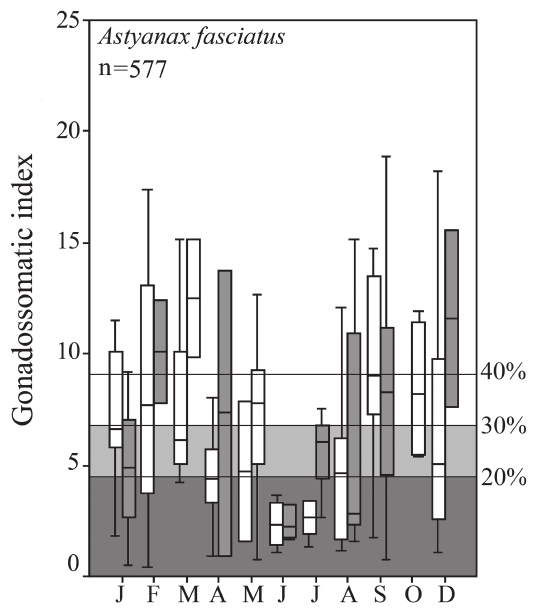
Fig. 4. Monthly variation of Hoplias malabaricus GSI values (adult females only) in Guaíba Lake (white) and Casamento Lake (dark gray), Rio Grande do Sul, Brazil (median, 25-75% quartiles and lower-upper GSI limits by month and site). Three GSI cut-off values were tested with respect to the maximum GSI recorded for each species, for delimitation of